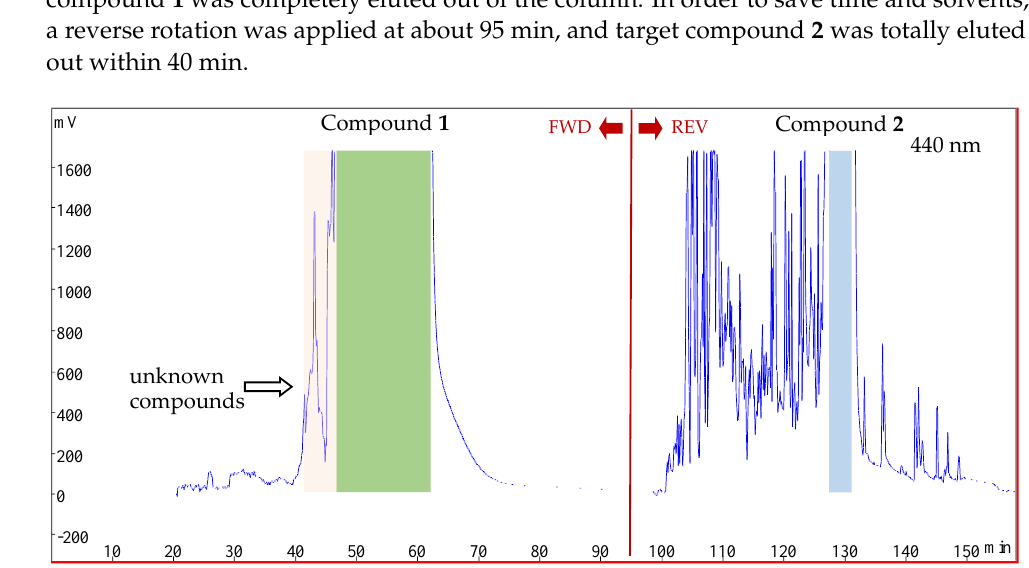
Figure 3. HSCCC purification of crocins I and II from the crocin-containing fraction by forward and reverse rotation.